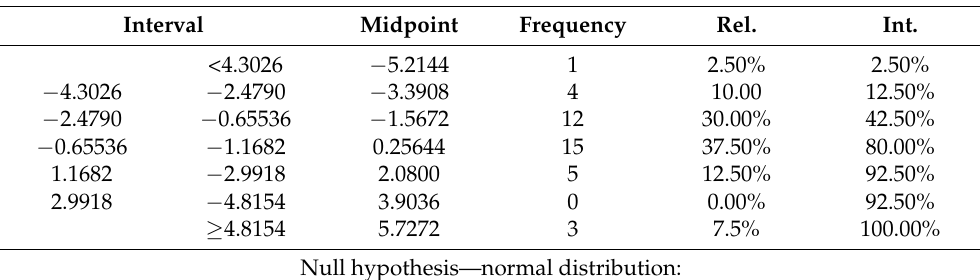
Table 17. Frequency allocation for model